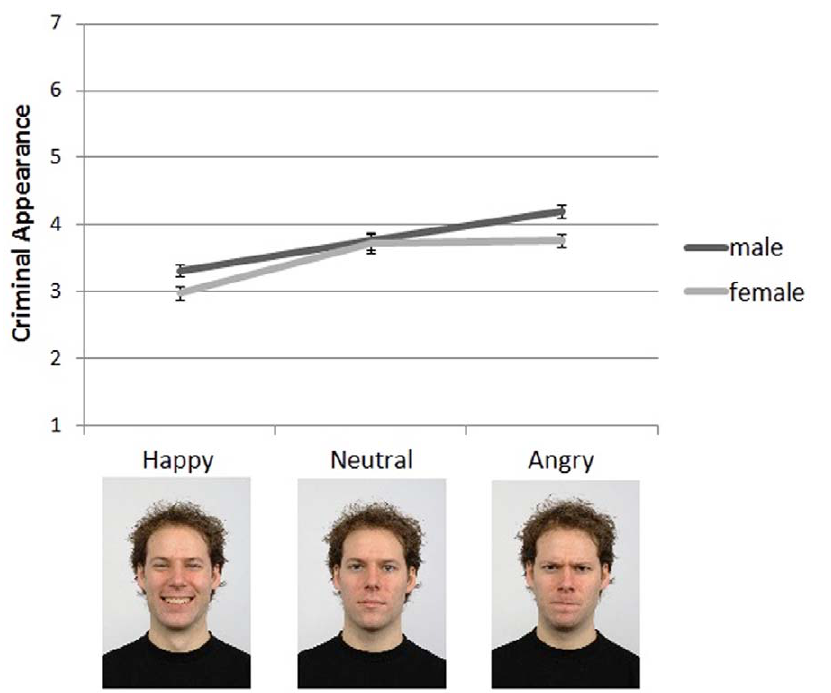
Figure 3. Mean ( ± 1 SE ) criminal appearance ratings of the controlled faces by emotional expression condition and actor gender. Examples of the male face stimuli are presented along the x-axis for each emotion condition. Female stimuli not shown; visit http://www.socsci.ru. nl:8180/RaFD2/RaFD?p=main for further information about the face stimuli.